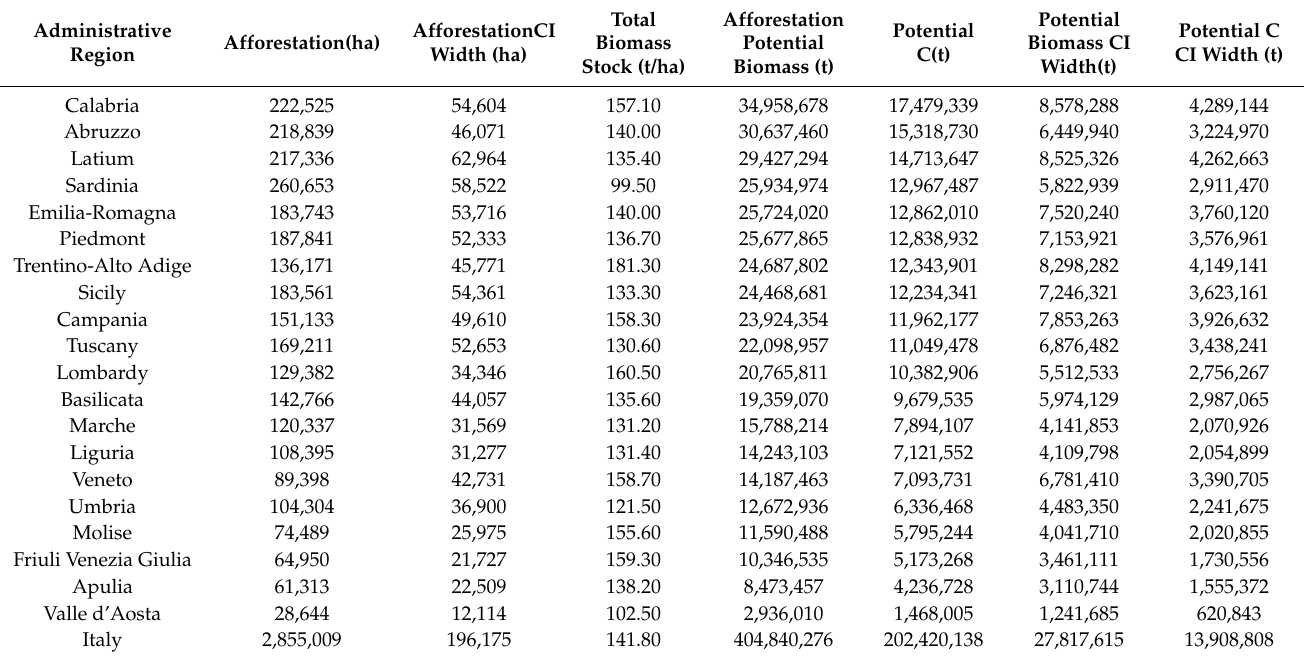
Table A5. Potential C-sequestration (t) and CI width (t) estimated in administrative regions in afforestation areas between 1985 and